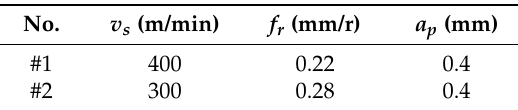
Table 7. Verification